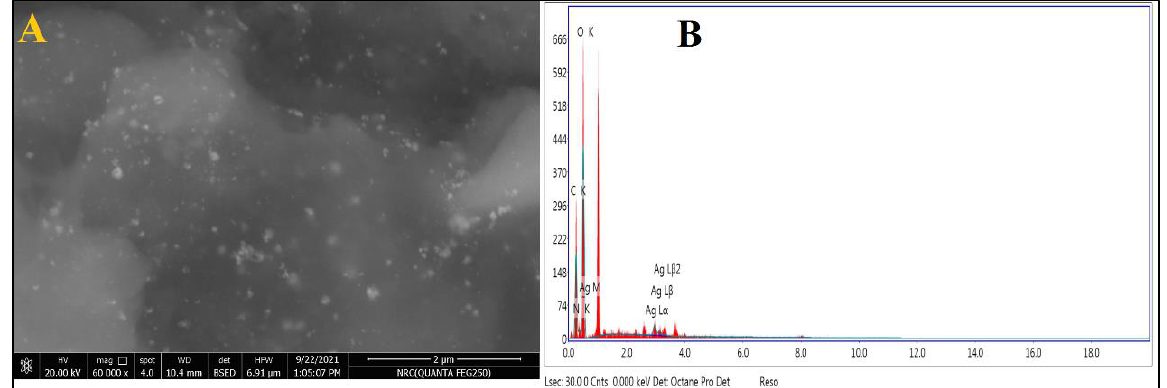
Figure 3. ( A ) SEM image and ( B ) EDX spectrum of prepared